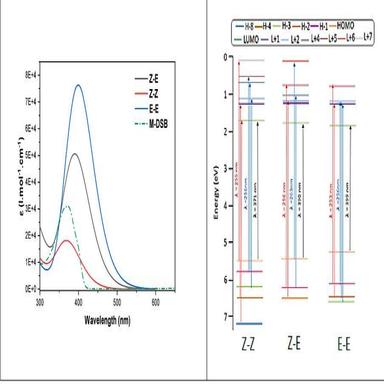
a) Theoretical UV–vis spectra in chloroform solution of different isomers of M-DSB, in comparison with its experimental spectrum. b) The main electronic transitions in different isomers.